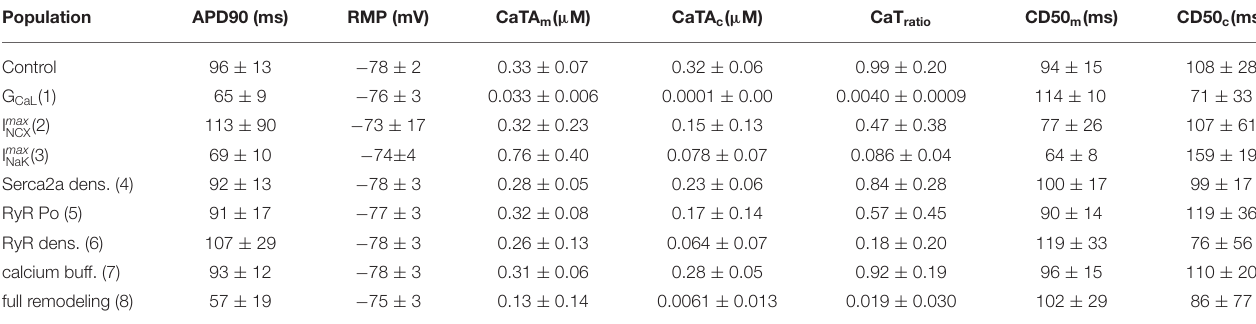
TABLE 2 | AP and CaT properties (mean ± std) of the control and remodeled populations.